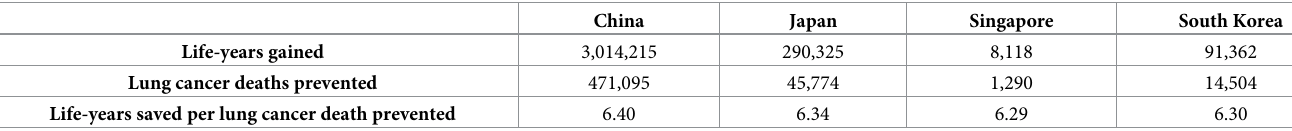
Table 4. Projected life-years gained,